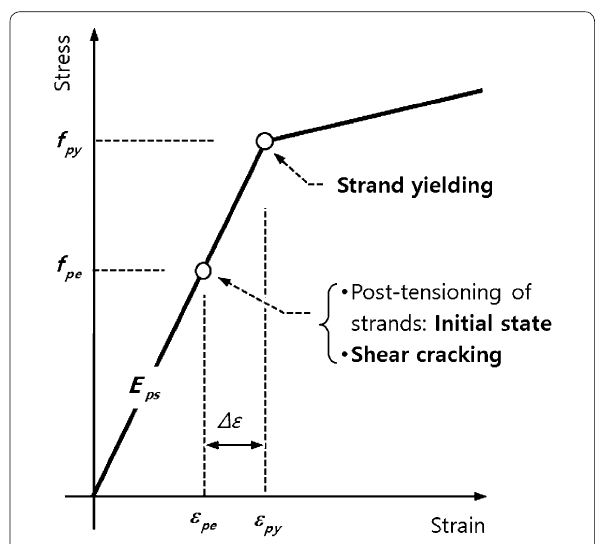
Fig. 11 Behavior of PS strands under post‑tensioning and lateral loading.